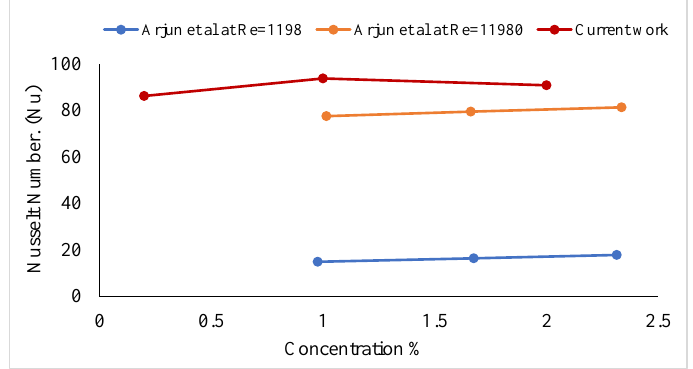
Figure 22. Interaction of Nusselt number values with different concentrations of Nanofluid.